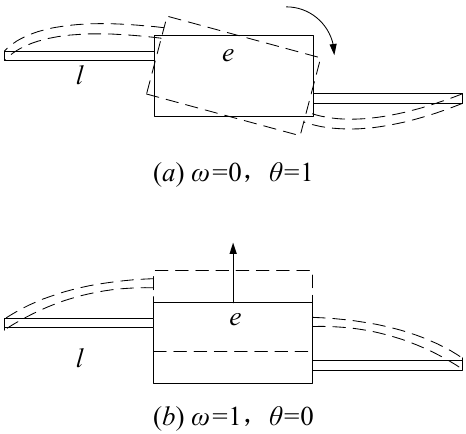
Figure 8. The influence coefficient method. ( a ) ω = 0, θ = 1 ( b ) ω = 1, θ = 0.